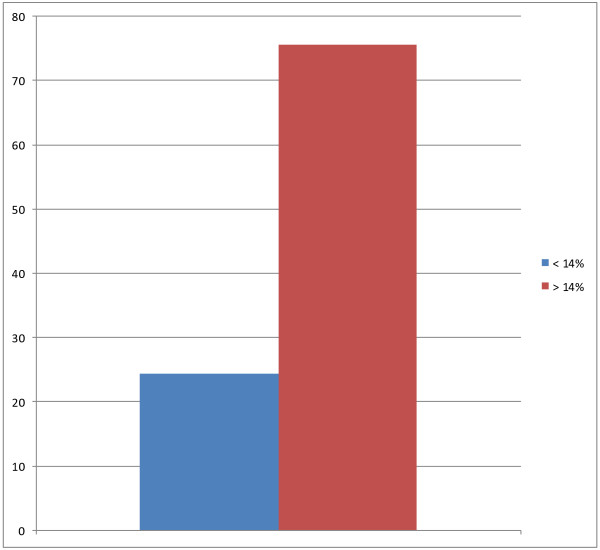
Distribution by the proliferation index assessed by Ki 67.